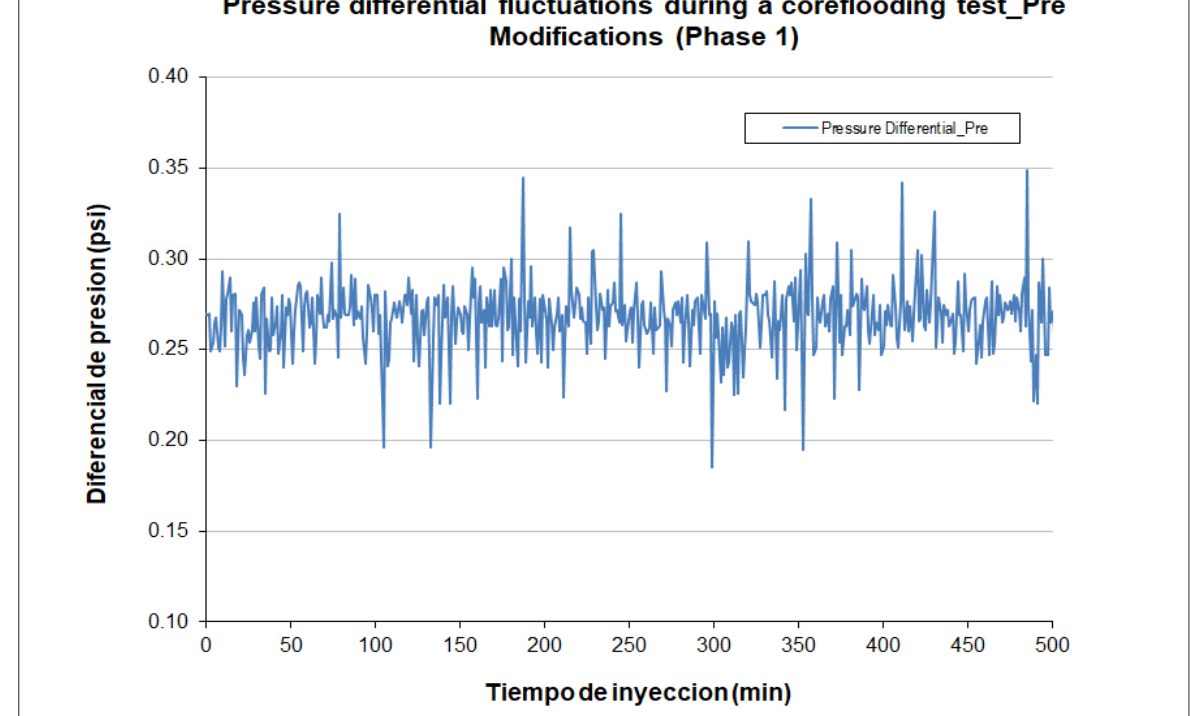
Figure 4: Pressure differential fluctuations during a coreflooding